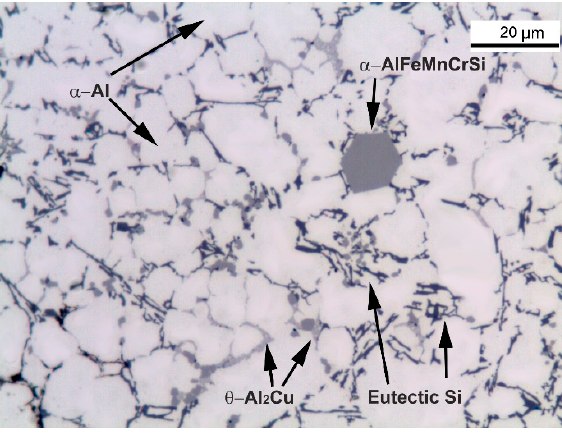
Figure 2. OM micrograph of diecast base alloy (Alloy 1).